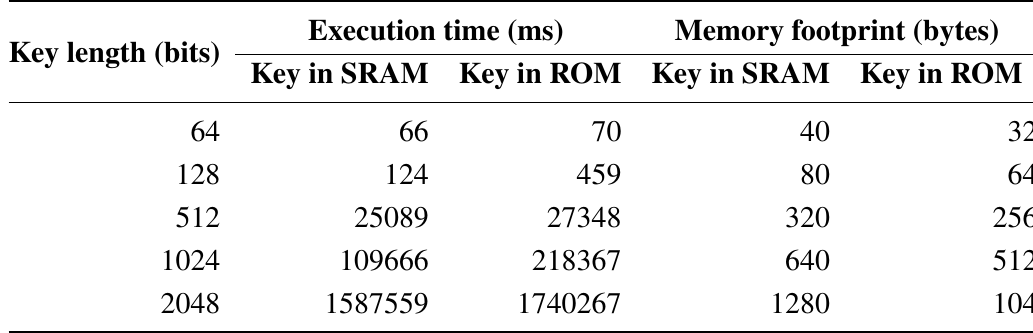
Table 3. RSA private key operation performance.